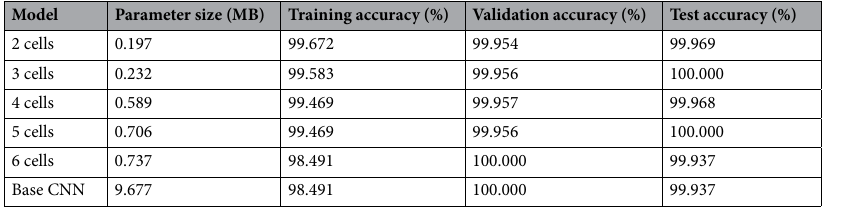
Table 7. Comparison of CNNs with the different number of cells.